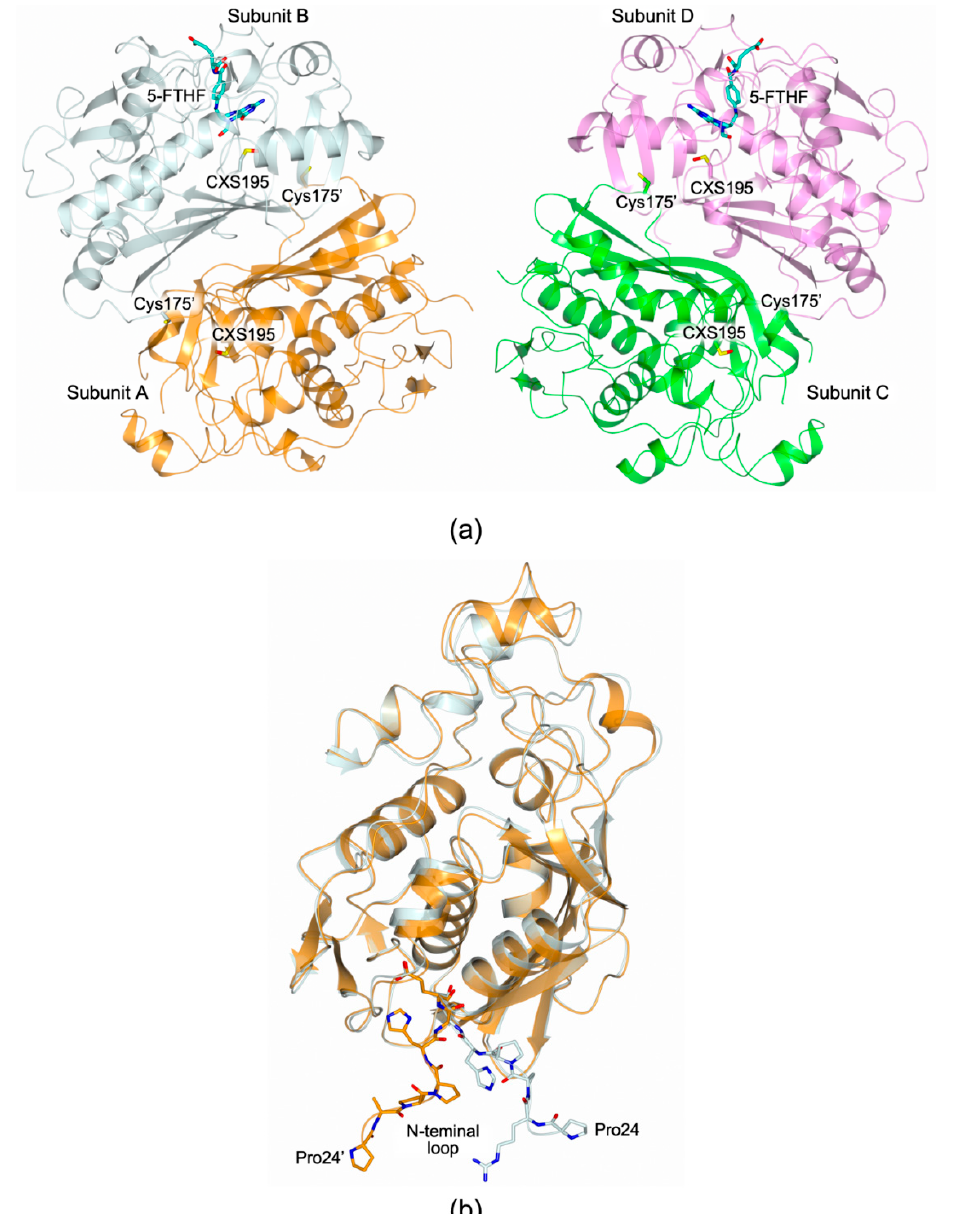
Figure 2. ( a ) Cartoon representation of the two homodimers (A-B and C-D, in our model) found in the cell ASU (subunit A is coloured orange, B light cyan, C green and D pink) of HT-hTS R175C. Within each enzyme homodimer, both subunits assume the active conformation, showing the catalytic Cys195 exposed inside the active site. In all subunits, the catalytic Cys195 is modified as S-oxy-cysteine (CSX195, in sticks, carbon atoms are color-coded according to the parent subunit). The mutated residue Cys175 is displayed in sticks (carbon atoms are color-coded according to the parent subunit). Both enzyme dimers display asymmetrical ligand binding within their active sites, indeed the cofactor analogue 5-formyl-6-tetrahydrofolate (5-FTHF, in sticks, cyan carbons) is entrapped in the active site of subunit B and D. ( b ) The structural comparison between subunit A and B shows that their N -terminal segments point in two distinct directions (residues 24–30 are shown in sticks, carbon atoms are color-coded according to the parent subunit). The maximal displacement of 19.75 ( ± 0.48) Å, is observed between Pro24 of two partner subunits (measured between their C α atoms).